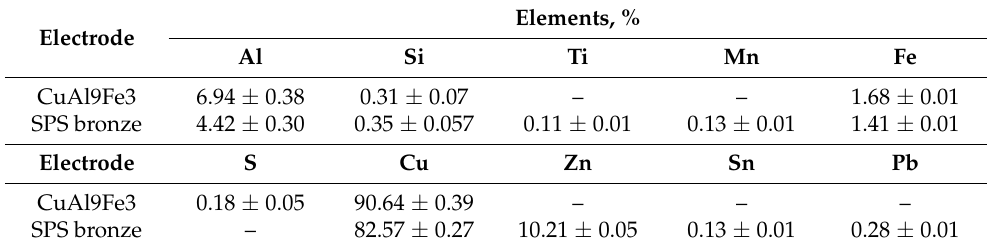
Table 2. Chemical composition of the electrodes.